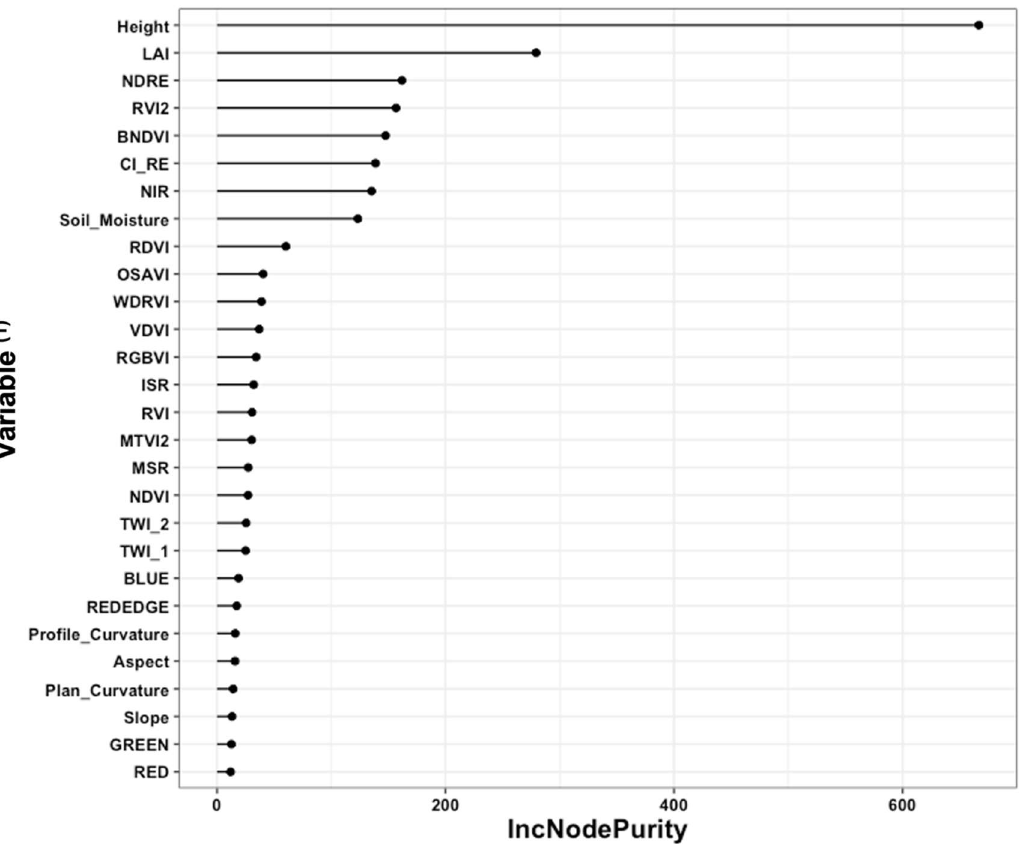
Figure 5. Variance Importance plot produced by the UAV RF regression model of data from 12, 20, and 27 May and 28 variables, using the function varImpPlot() in RStudio. Higher IncNodePurity values indicate more impact on canopy nitrogen estimation. (1) Please refer to Table 1 for the full